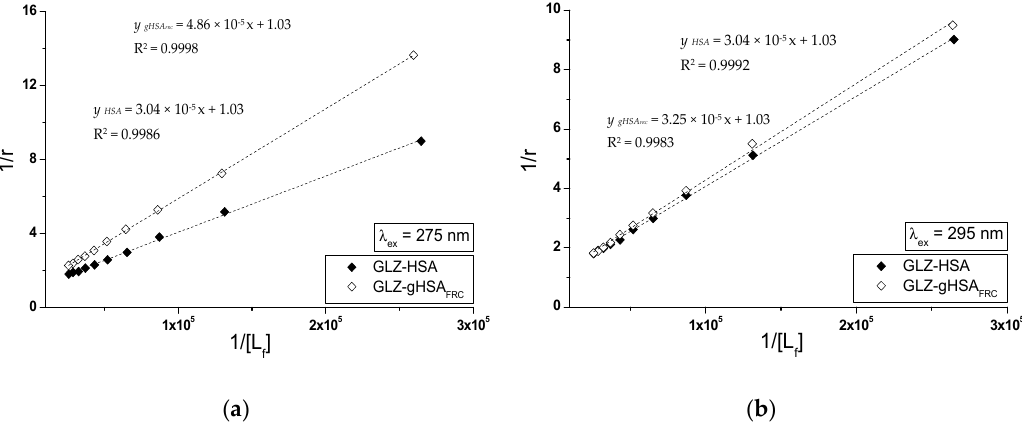
Figure 9. The Klotz curves for GLZ-HSA and GLZ-gHSA FRC . ( a ) λ ex = 275 nm and ( b ) λ ex = 295 nm; the error bars are smaller than the symbols.